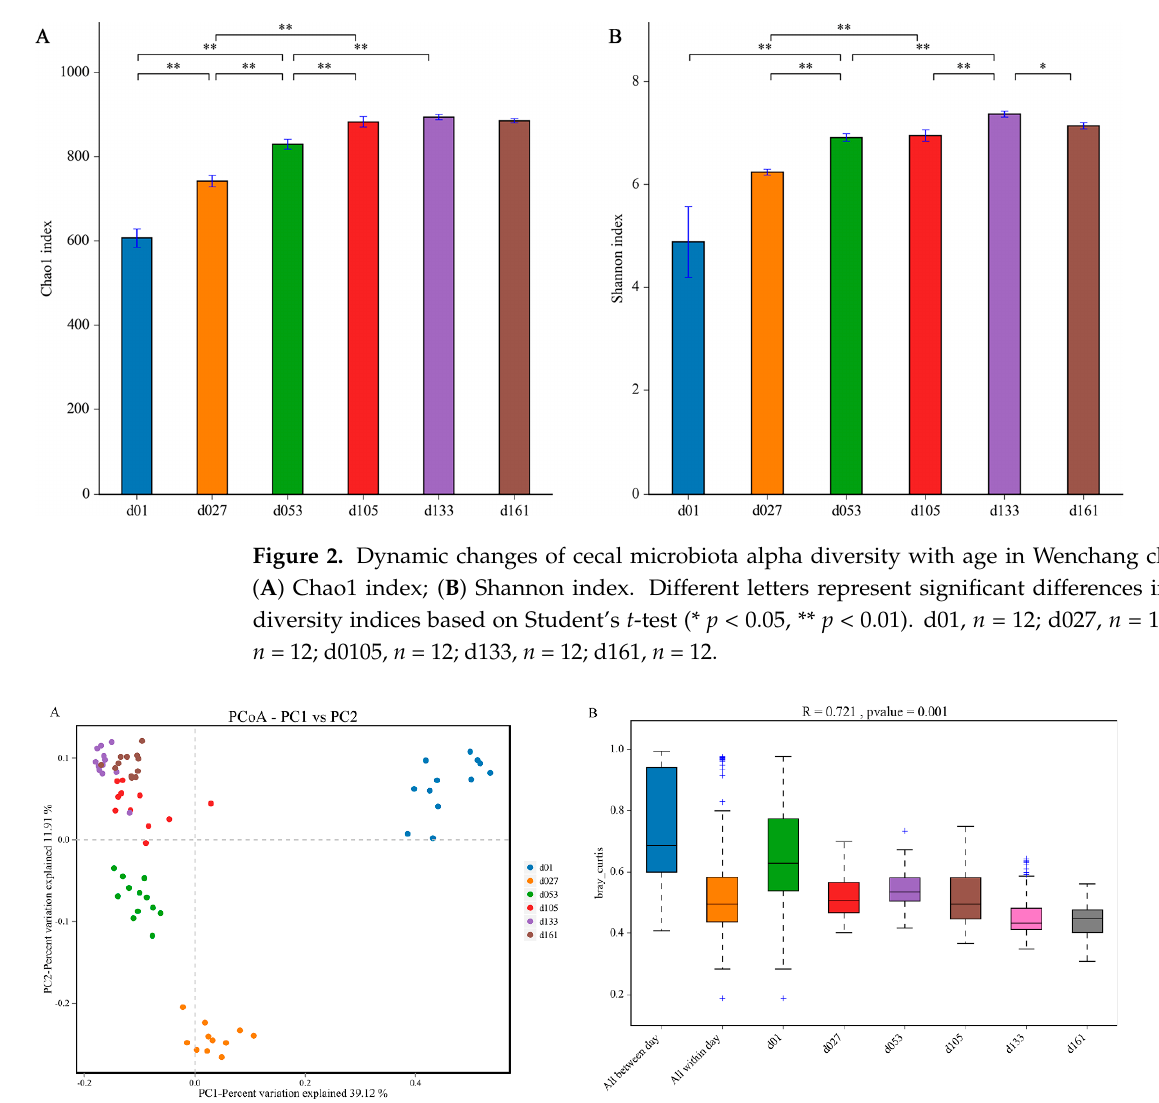
Figure 3. Dynamic changes of cecal microbiota beta diversity with age in Wenchang chickens. ( A ) Principal coordinates analysis (PCoA) based on Bray-Jaccard method. ( B ) Anosim based on the Bray-Curtis method. d01, n = 12; d027, n = 11; d053, n = 12; d0105, n = 12; d133, n = 12; d161, n = 12.